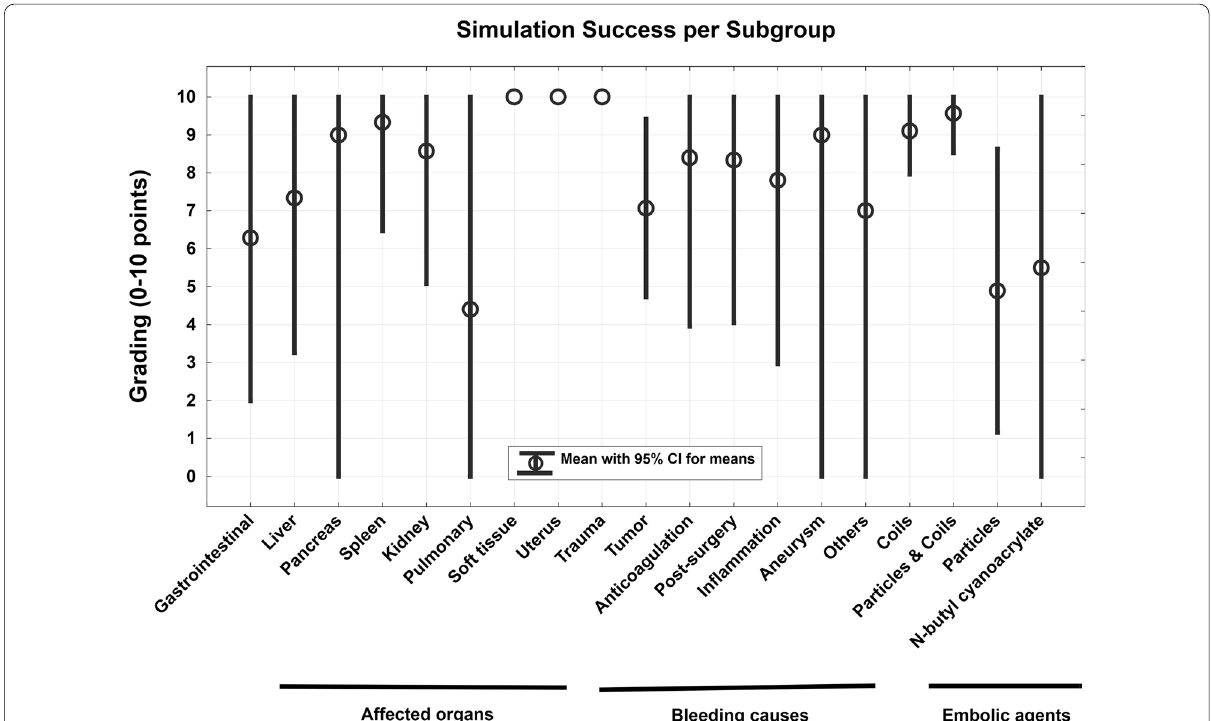
Fig. 7 Box plots for simulation success. Simulation success is listed in groups of affected organs, bleeding causes and embolic agents. The simulation success in the 10-point grading scale was significantly reduced in pulmonary embolization ( p tissue ( p 0.032) and coil embolizations ( p = =